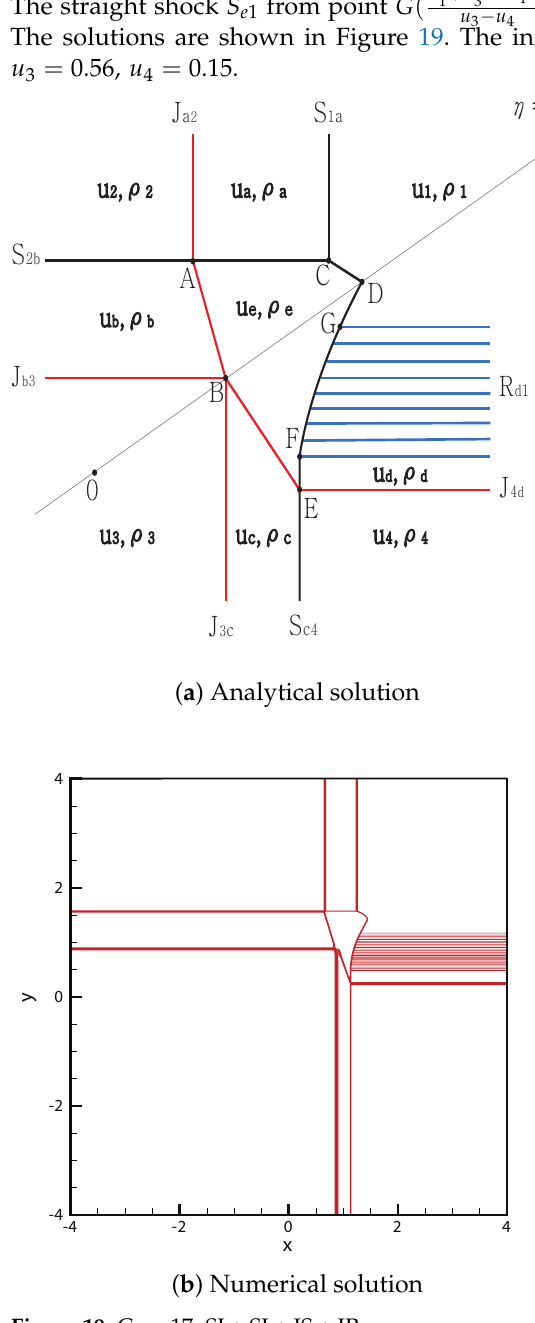
Figure 19. Case 17. SJ + SJ + JS +